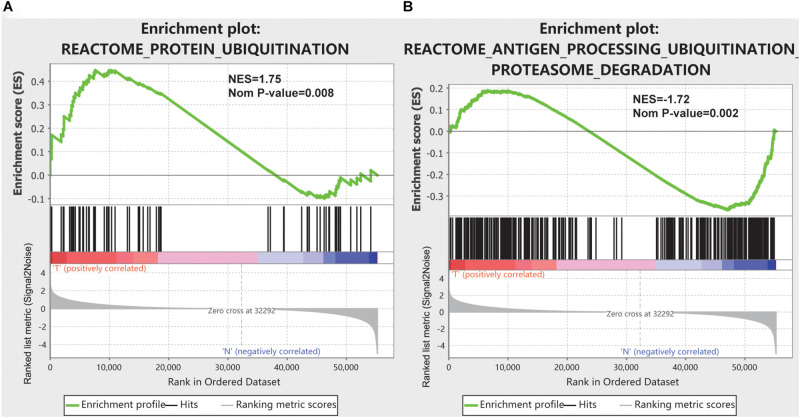
GSEA results for the enrichment plots of two gene sets (REACTOME_ANTIGEN_PROCESSING_UBIQUITINATION_PROTEASOME_DEGRADATION, and REACTOME_PROTEIN_UBIQUITINATION) that were significantly differentiated in normal and pancreatic cancer tissues based on TCGA database. (A) Enrichment plot of the REACTOME_ANTIGEN_PROCESSING_UBIQUITINATION_PROTEASOME_DEGRADATION gene set. (B) Enrichment plot of the REACTOME_PROTEIN_UBIQUITINATION gene set.